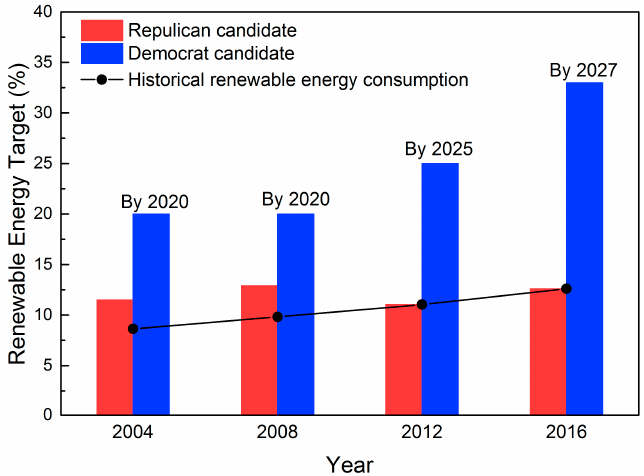
Figure 4. Trends of partisan difference on energy policy.